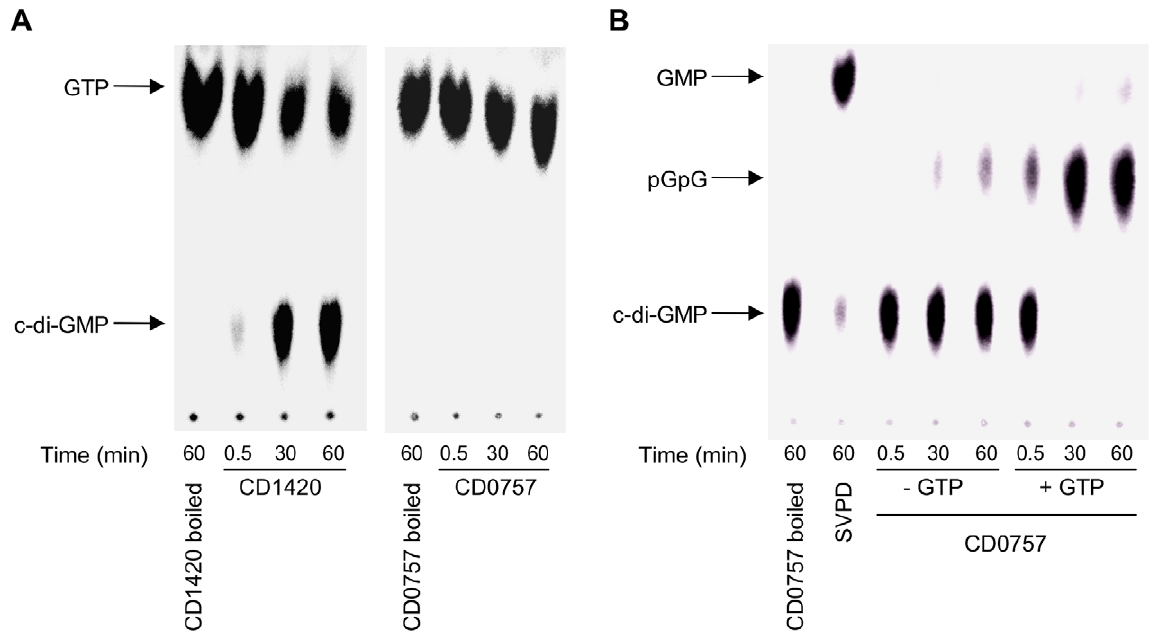
Figure 5. TLC analysis of the enzymatic activities of CD1420 and CD0757. (A) DGC activity of purified CD1420. (B) PDEA activity of purified CD0757. Snake venom phosphodiesterase (SVPD) was used as a positive